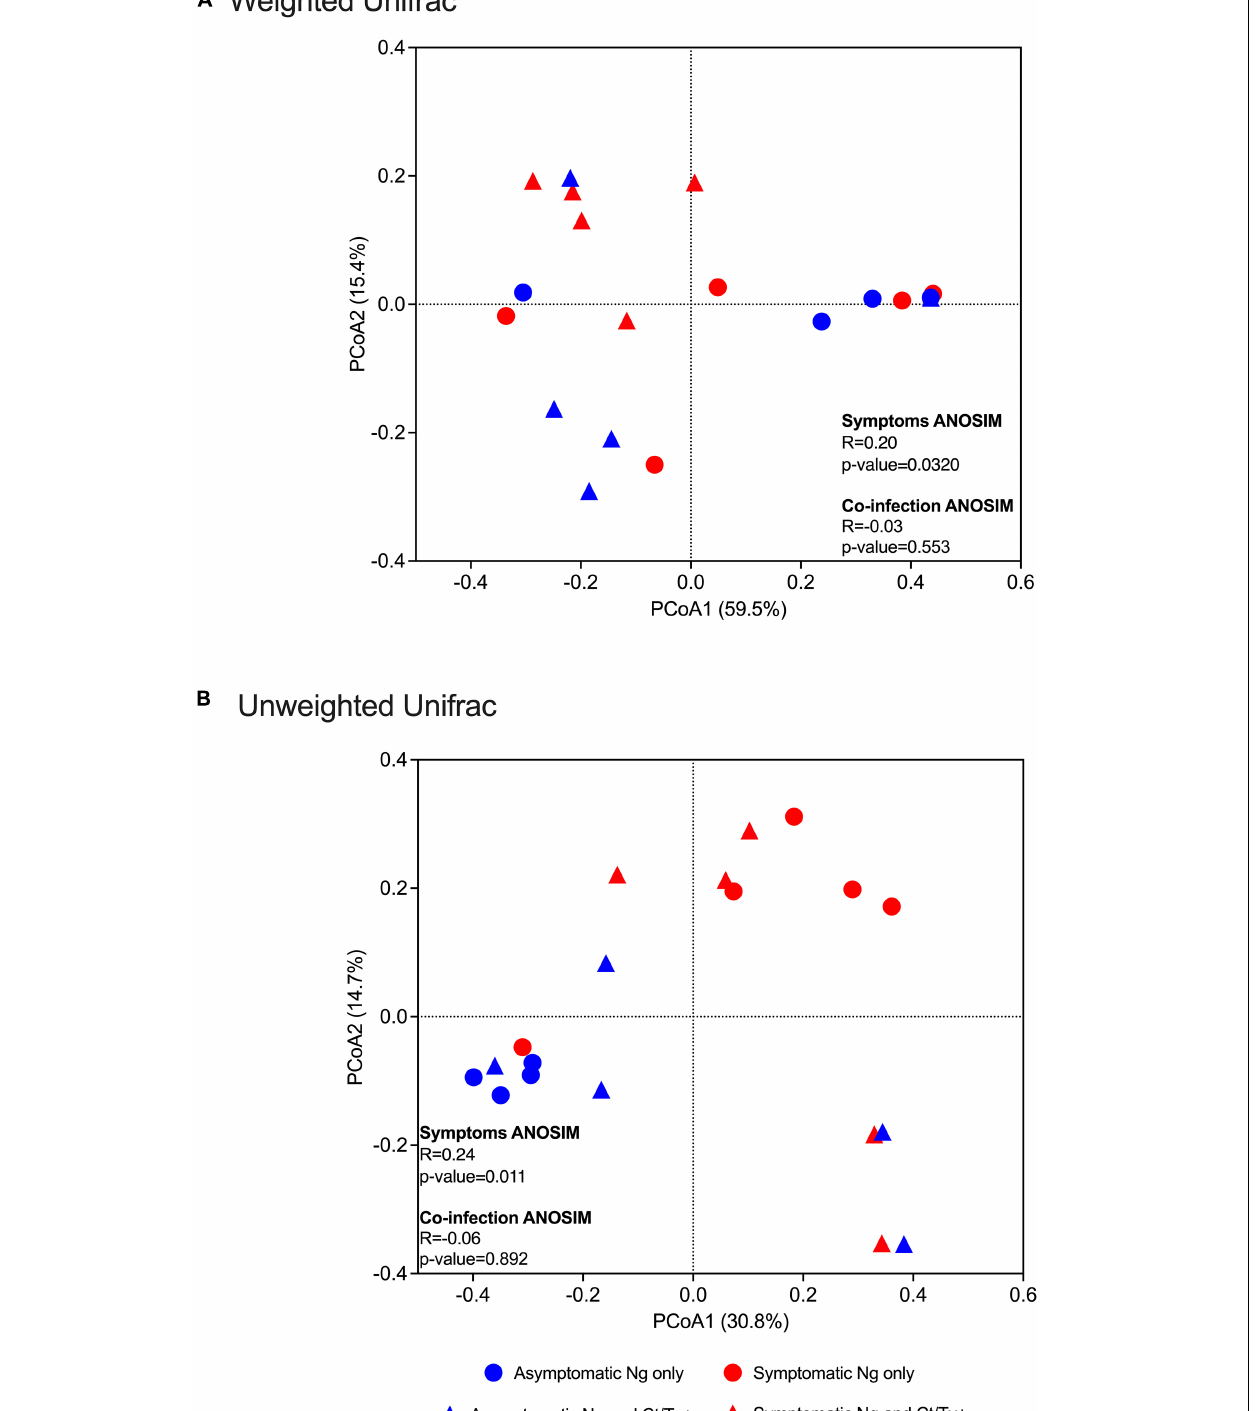
Frontiers in Microbiology |